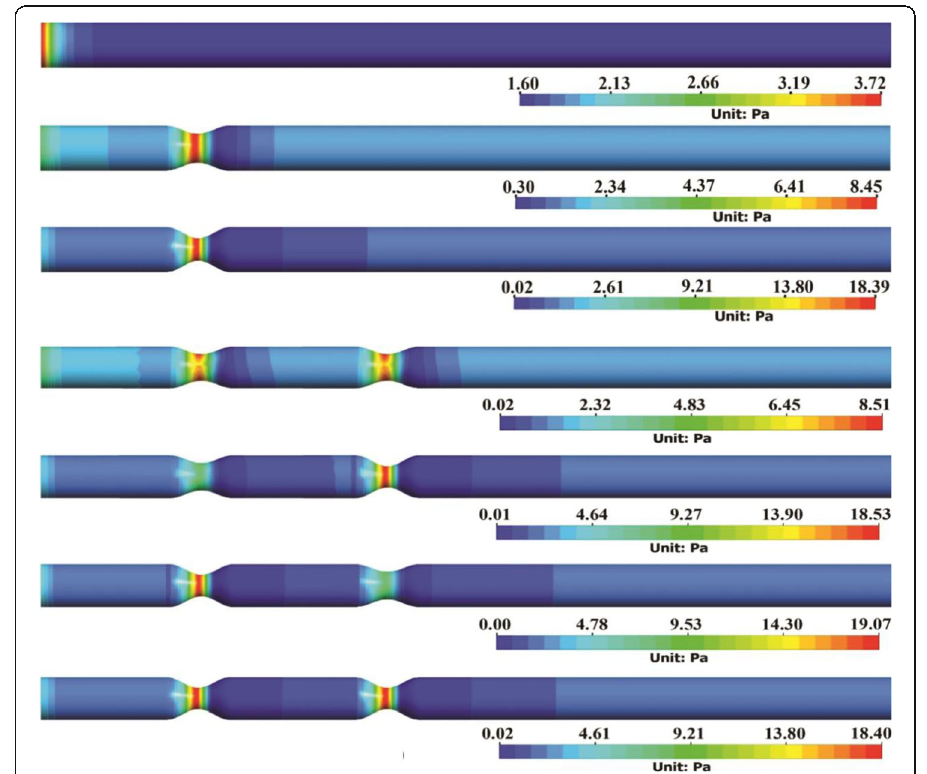
Fig. 9 Effect on wall sheer stress for single and multiple